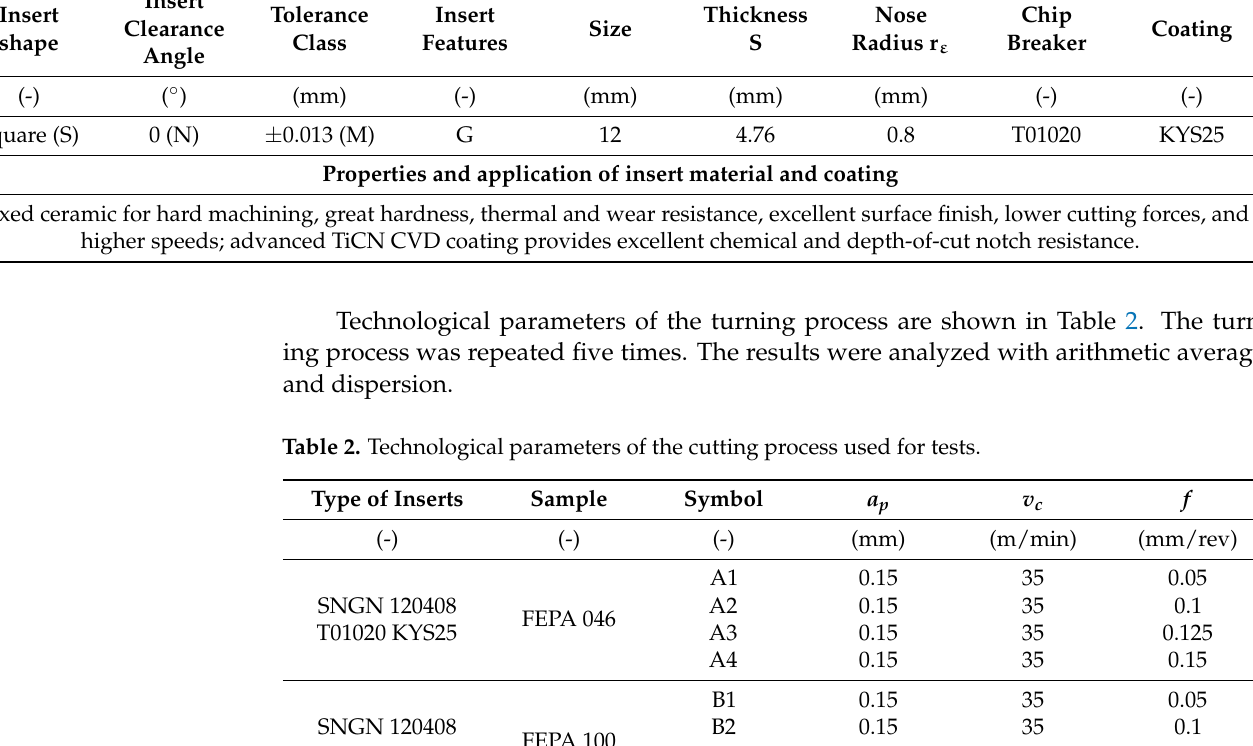
Table 1. Geometry and properties of cutting insert Kennametal SNGN 120408 T01020 KYS25.